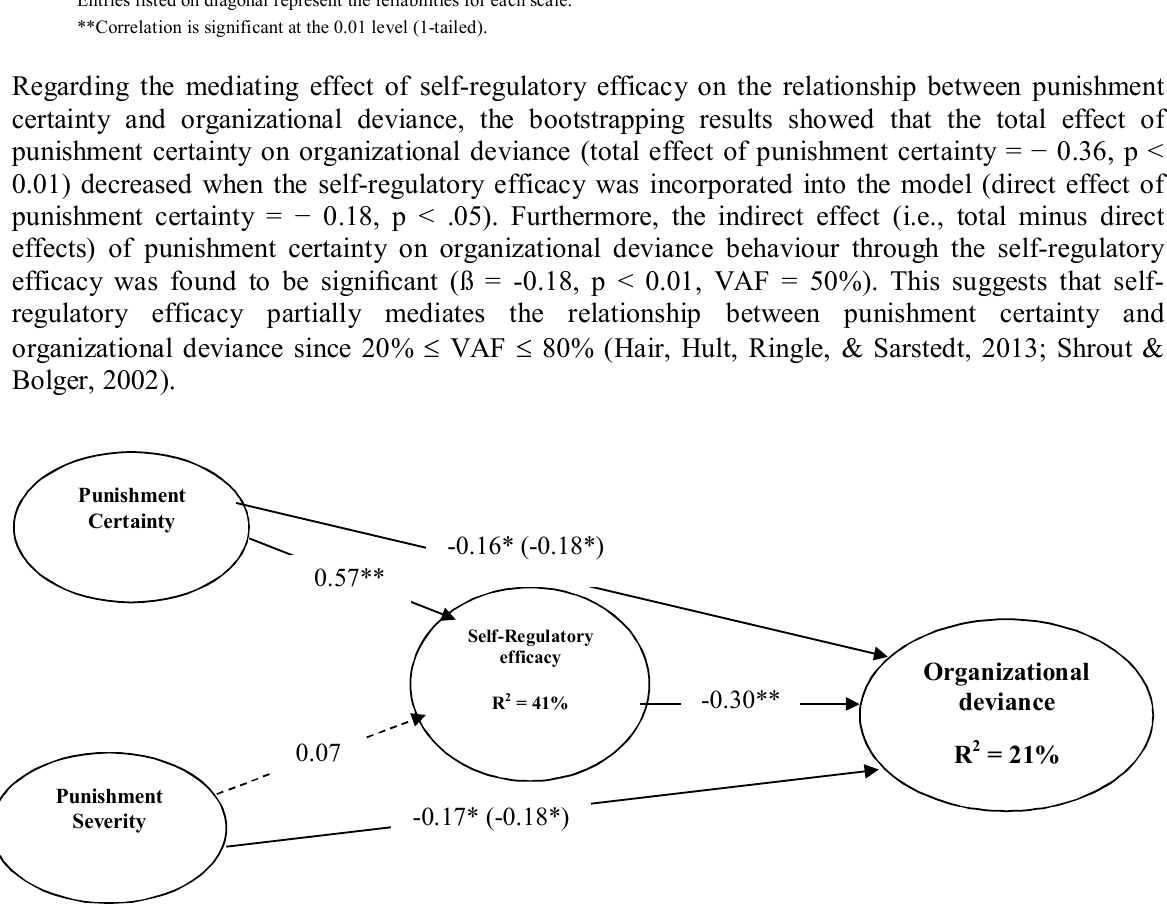
Fig. 1. The results of mediation analyses, based on 5000 bootstrap samples The path values represent unstandardized regression coefficient, while entries in parentheses represents the direct effect of punishment certainty and punishment severity on organizational deviance after incorporating self-regulatory efficacy into the